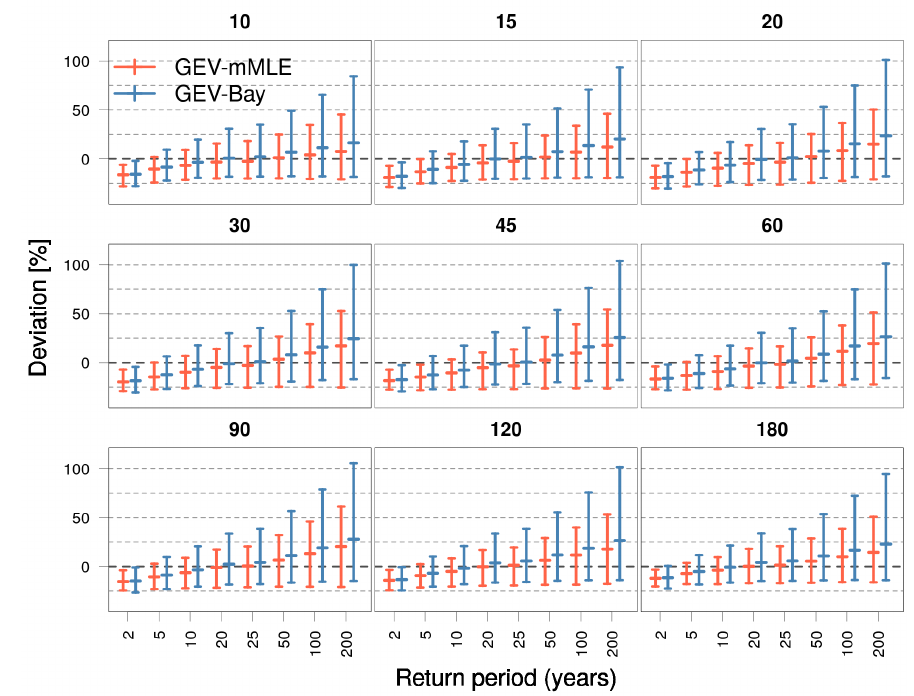
Figure 3. Relative difference to return levels from Gumbel-RV for GEV-mML (red) and GEV-Bay (blue) at station 18701 Oslo-Blindern for the durations of 10–180 min and all return periods. The bars indicate the 95% confidence or credible